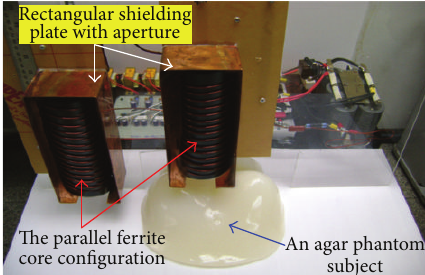
Figure 10: Constructions of shielding system for verifying the numerical and simulation results, in which the experiment of proposed system consists of high power oscillator, induction coils applicator with shielding plates, and agar phantom. The distance between both ferrite cores is equal to 18cm from consideration of shielding plate design mentioned